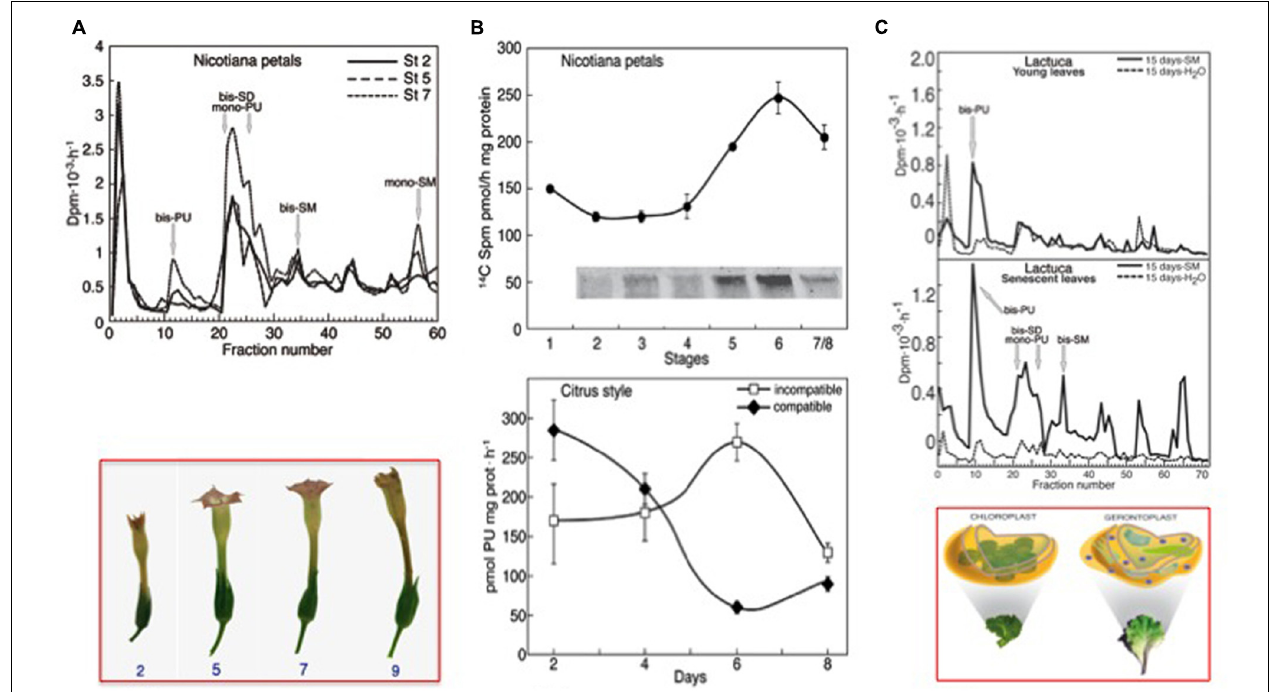
insert [modified from Della Mea etal. (2007b)]. Bottom panel:TGase activity in compatible and self-incompatible pollinated styles of Citrus grandis at different days of pollination.The activity was detected by incubating style extracts in the presence of [ 3 H]-PU as the tracer (modified from Gentile etal., 2012). At day 6, the incompatible pollen tube growth was blocked. (C) Senescing leaves of Lactuca sativa compared with the young ones. Glutamyl-PAs were separated by ion-exchange chromatography from extracts of young and senescing leaves, sprayed with SM or water when still on the plant and extracted 15 days after the spray. Extracts were incubated for 60 min with [ 3 H] SM as tracer in the assay mixture containing 5 mM Ca 2 + . Bottom panel: picture of the Lactuca leaves and related plastids [modified from Serafini-Fracassini etal.